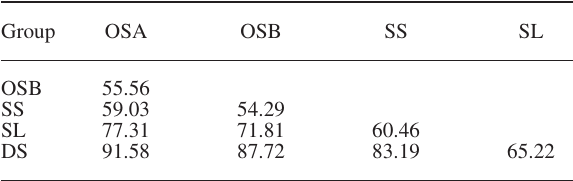
Table 2. – Average percentage dissimilarity between species for the groups obtained by the ordination techniques as determined by the ANOSIM procedure. See legend to Figure 2.